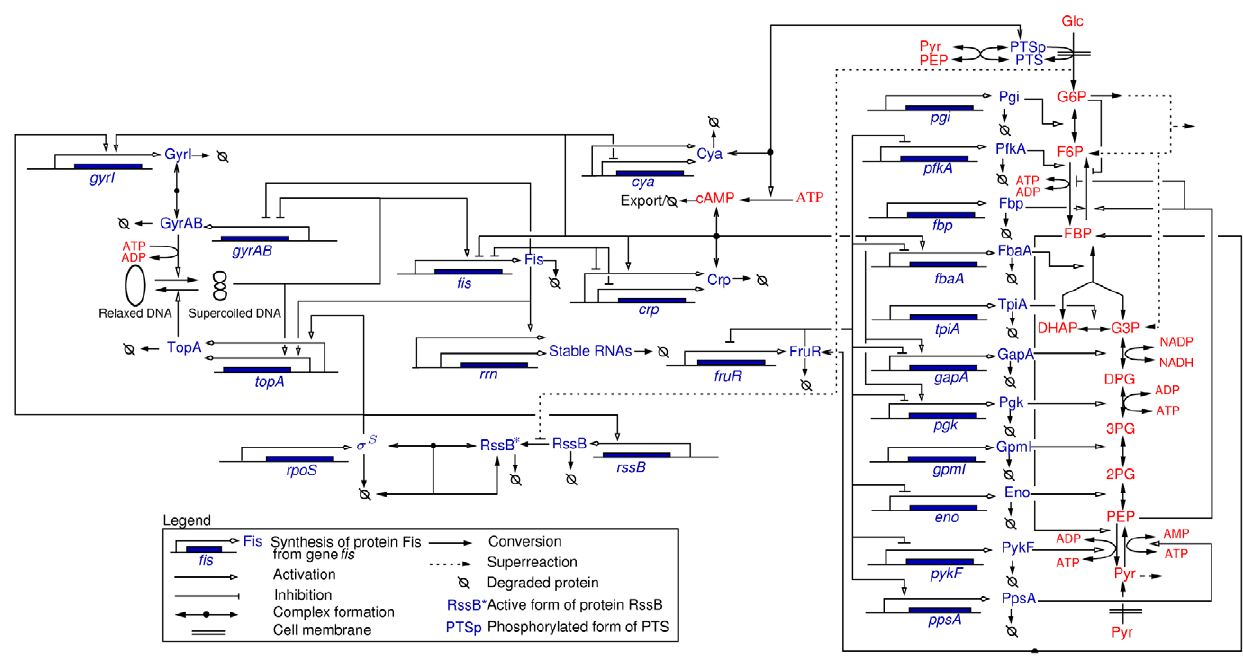
Figure 4. Network of key genes, proteins, and regulatory interactions involved in the carbon assimilation network in E.coli . The graphical conventions [52] are explained in the legend. The metabolic part includes the glycolysis/gluconeogenesis pathways as well as a simplified description of the PTS system (adapted from [30]), via the phosphorylated and non-phosphorylated form of its enzymes (represented by PTSp and PTS, respectively). The pentose-phosphate pathway (PPP) is not explicitly described but we take into account that a small pool of G6P escapes the upper part of glycolysis. Graphically, the PPP is represented as a ‘super-reaction’, in which elementary steps are lumped together. At the level of the global regulators the network includes the control of the DNA supercoiling level, the accumulation of the sigma factor RpoS and the Crp : cAMP complex, and the regulatory role exerted by the fructose repressor FruR. A complete description of the model can be found in Sec. 1 of Text S3. Proteins are shown in red, and metabolites in